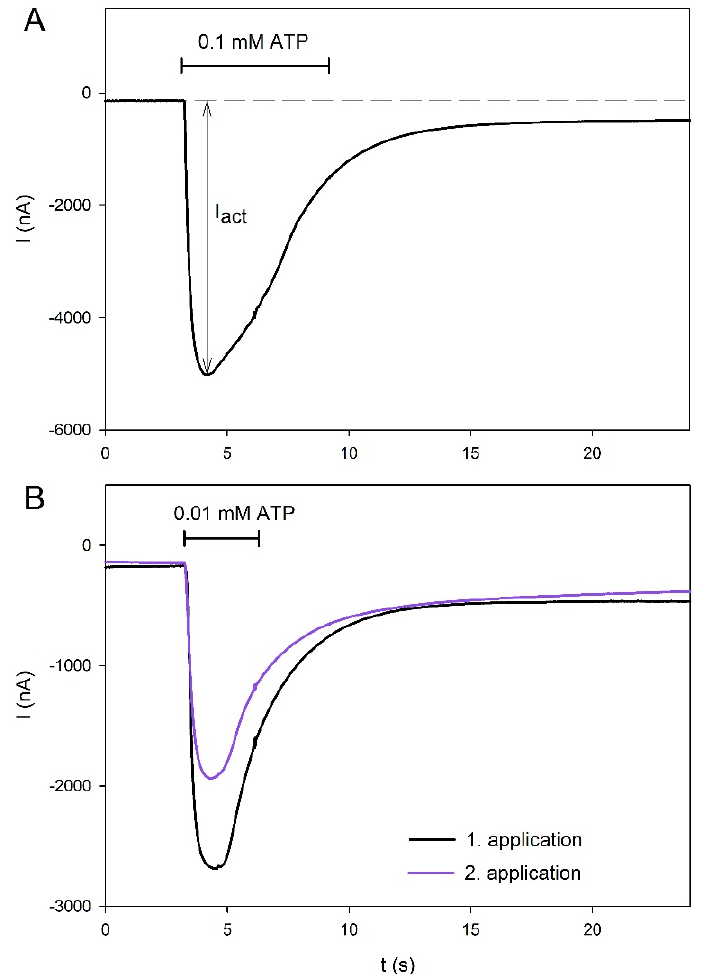
Figure 1. Examples of hP2X5 FL -mediated current traces in X. laevis oocytes elicited by ATP. ATP was applied for 6 s ( A ) or 3 s ( B ) at the indicated ATP concentration and for the duration indicated by the horizontal line. In ( B ), a 2 min washout period was inserted between the first and second ATP applications. ATP